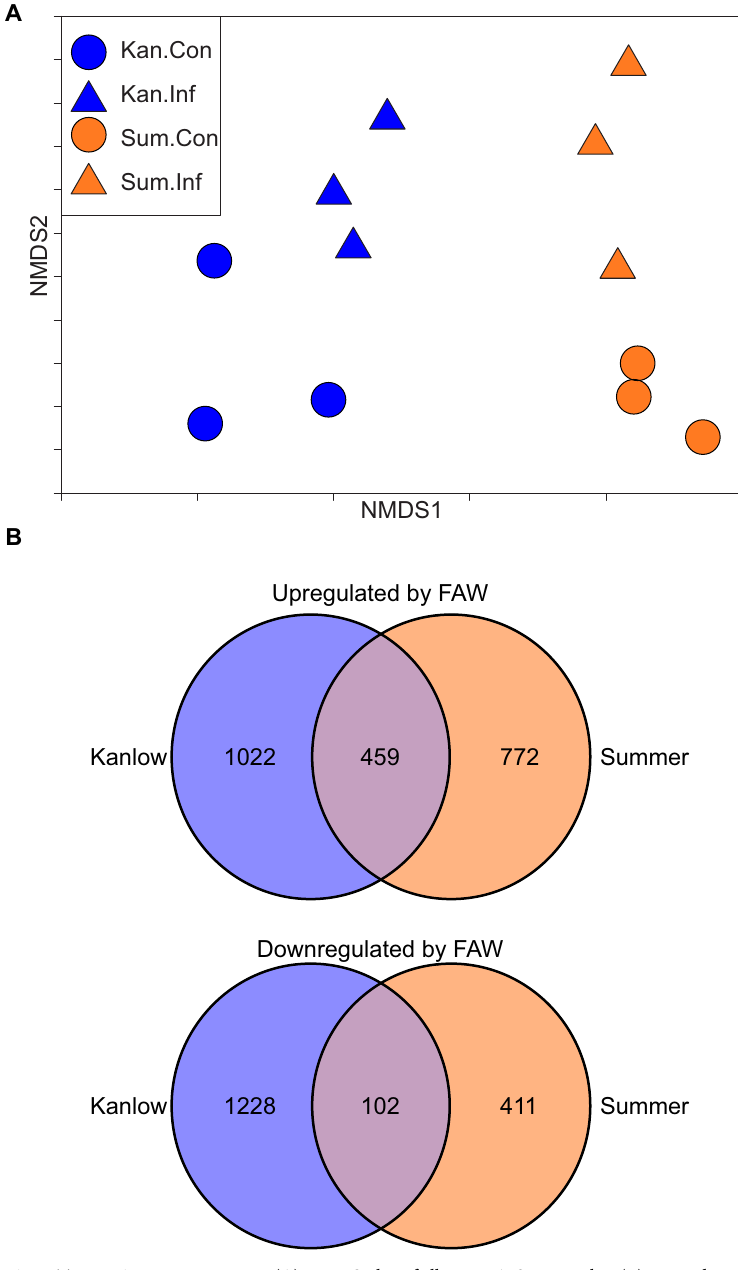
Fig 2. Transcriptome summary. (A) NMDS plot of all 12 RNA-Seq samples. (B) Venn diagrams showing the number of DEGs upregulated or downregulated by FAW in Kanlow and Summer switchgrass.